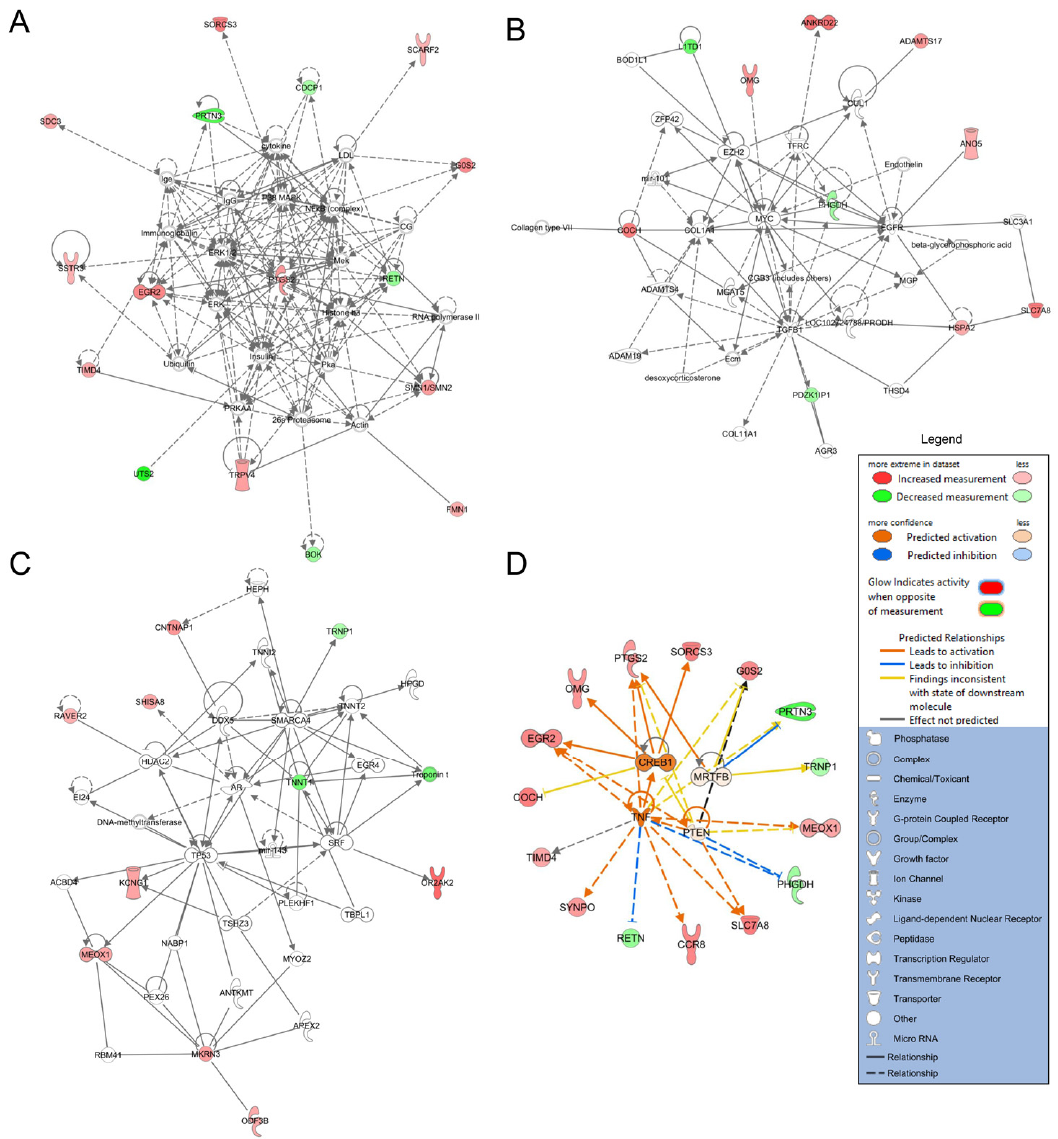
Figure 3. Ingenuity Pathway Analysis results. Networks and upstream regulators were derived from IPA using differentially expressed genes in PBMCs from IA patients and controls. Genes with increased expression levels in patients with IAs are red, and genes with lower expression levels in patients with IAs are green, while fold-change is represented by color intensity. Non-differentially expressed transcripts with known interactions are not colored. Direct and indirect relationships are shown by solid and dashed lines, respectively. ( A ) The first network ( p -score = 36) shows nodes of interactions to differentially expressed genes at NF-kB, PTGS2 (also differentially expressed), cytokines, and immunoglobulins. ( B ) The second network ( p -score = 20) shows nodes of regulation at TGFB, MYC, and PHGDH, as well as other interactions with ADAMTS family members and collagens. ( C ) The third network ( p -score = 20) shows nodes of regulation at TP53, SRF, and SMARCA4. ( D ) Predicted upstream regulators are shown in orange (activation) or blue (inhibition). This network of significant upstream regulators shows evidence that TNF and CREB1 may have a role in regulating predominantly genes with increased expression.